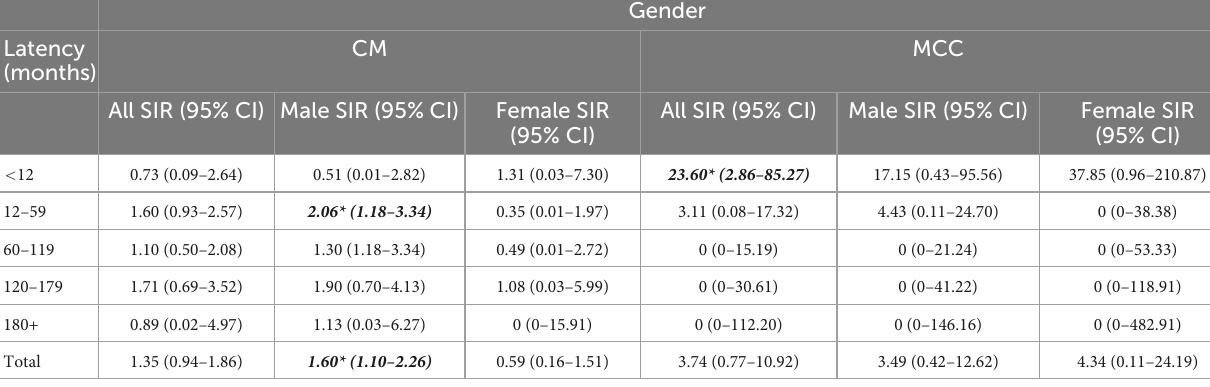
TABLE 3 Patient latency to diagnosis of CM and MCC from PCBCL stratified by